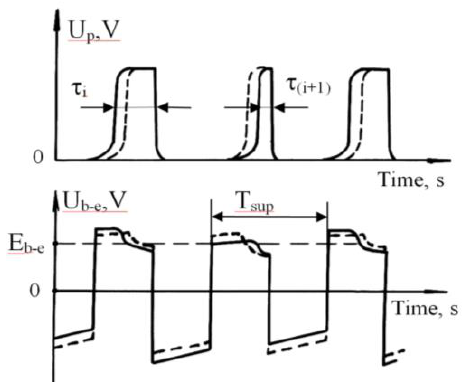
Fig. 4. The envelope shape of the output radio pulses U p and the control voltage U b-e in an unstable mode of operation of a super-regenerative